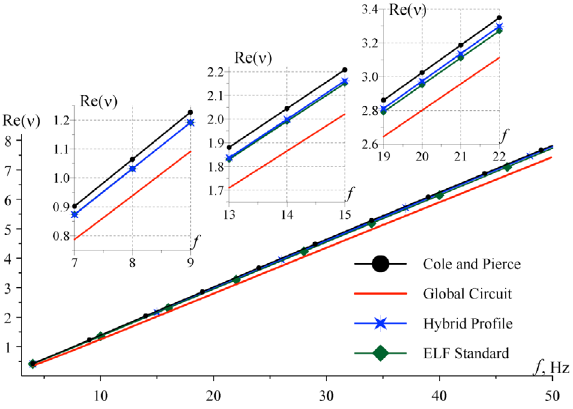
Figure 2. Real parts of the ELF propagation constant obtained with the full wave solution for the Cole and Pierce [1965] profile (black line with dots); profile based on the global circuit data (red smooth line); the hybrid profile (blue curve with stars). These are compared with the reference model (green curve with diamonds).